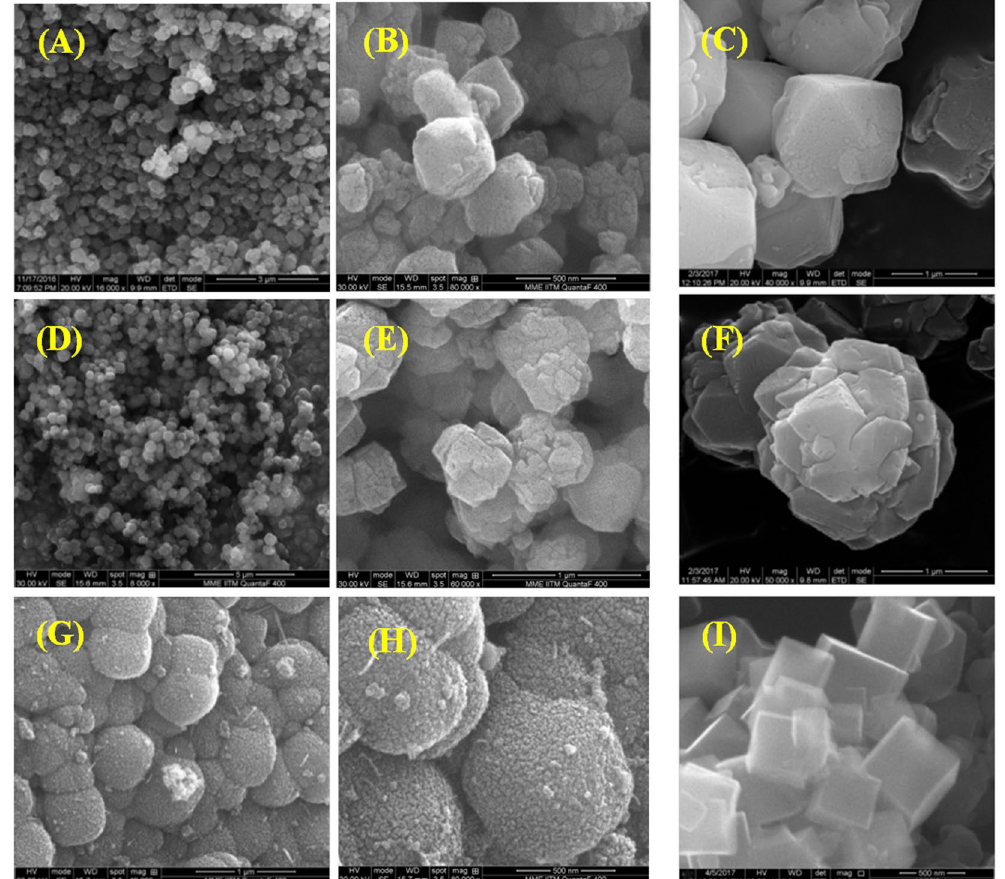
Figure 6. SEM images of various zeolites: ZH-Y ( A,B ) and Z-Y ( C ); ZH-X ( D,E ) and Z-X ( F ); (c) ZH-A ( G,H ) and Z-A ( I